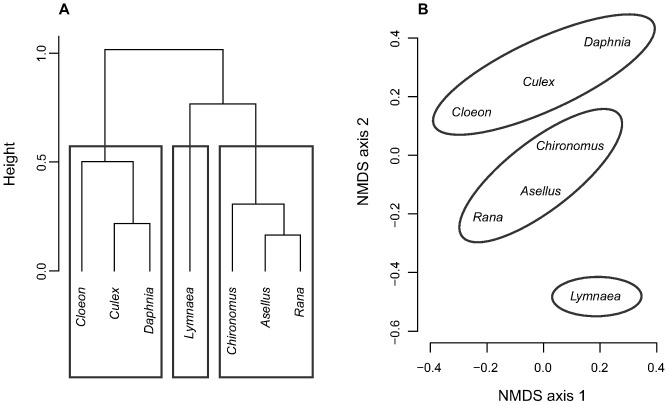
Similarity of predation pressure among prey species used in the experiment.A. Ward’s hierarchical clustering of the dissimilarities of predation pressure Dij; height = value of clustering criterion for the particular cluster. B. Predation pressure dissimilarities Dij visualised by nonmetric multidimensional scaling (NMDS, stress = 2.29), with groups identified by the cluster analysis highlighted; position of each species in the diagram corresponds to the centre of its label.